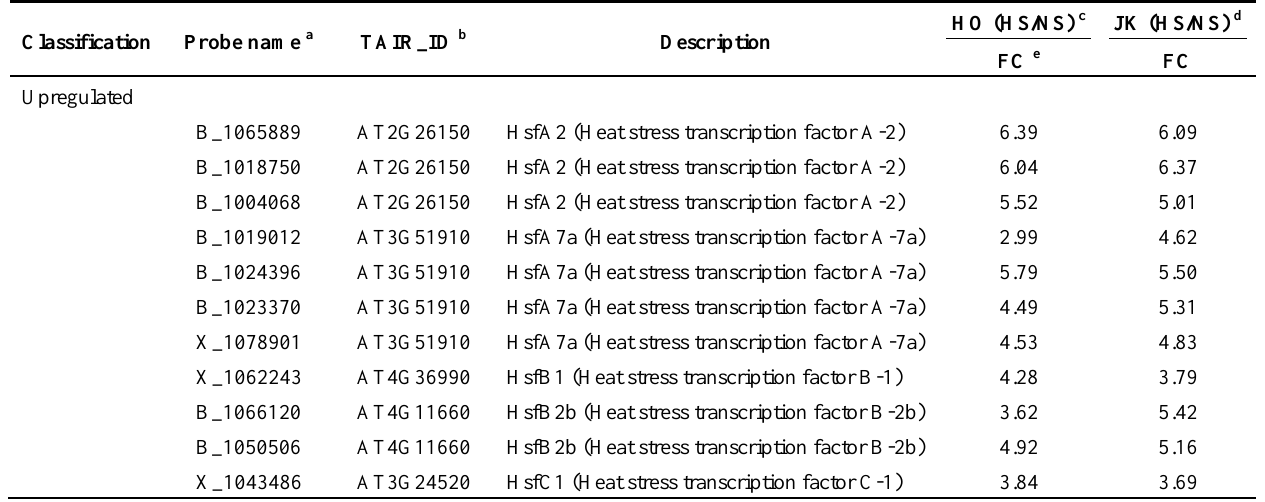
Figure 3. Validation of microarray data by quantitative real-time PCR. Transcript levels of a subset of up- and down-regulated genes from microarray data. Two-week-old plants were exposed to heat stress at 42 °C for 4 h (HS) or incubated at 24 °C (NS). ( a ) Transcript levels of upregulated genes in the heat stress condition in HO and JK lines. ( B_1087048 , Putative splicing factor ; B_1044548 , GRAS family transcription factor ; B_1048388 , 70 kDa heat shock protein ). HO is a heat-tolerant cabbage inbred line; JK is a heat-sensitive cabbage inbred line; ( b ) Transcripts levels of downregulated genes in the heat